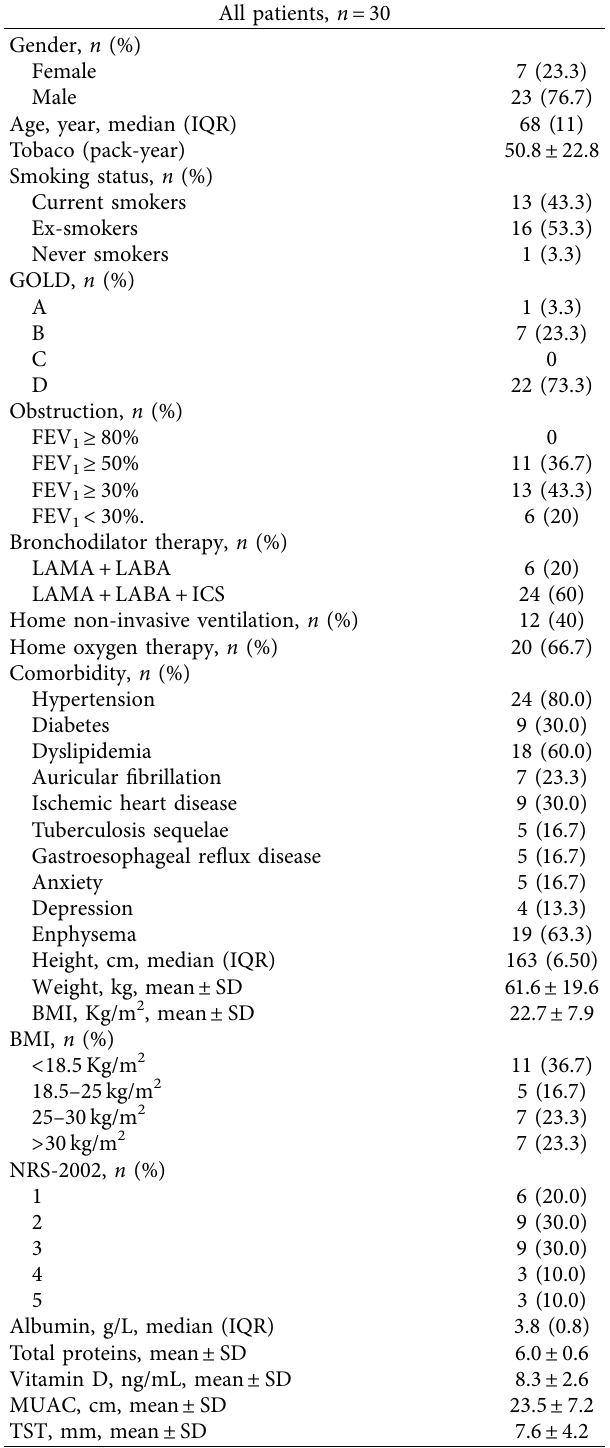
Table 1: General characteristics of COPD